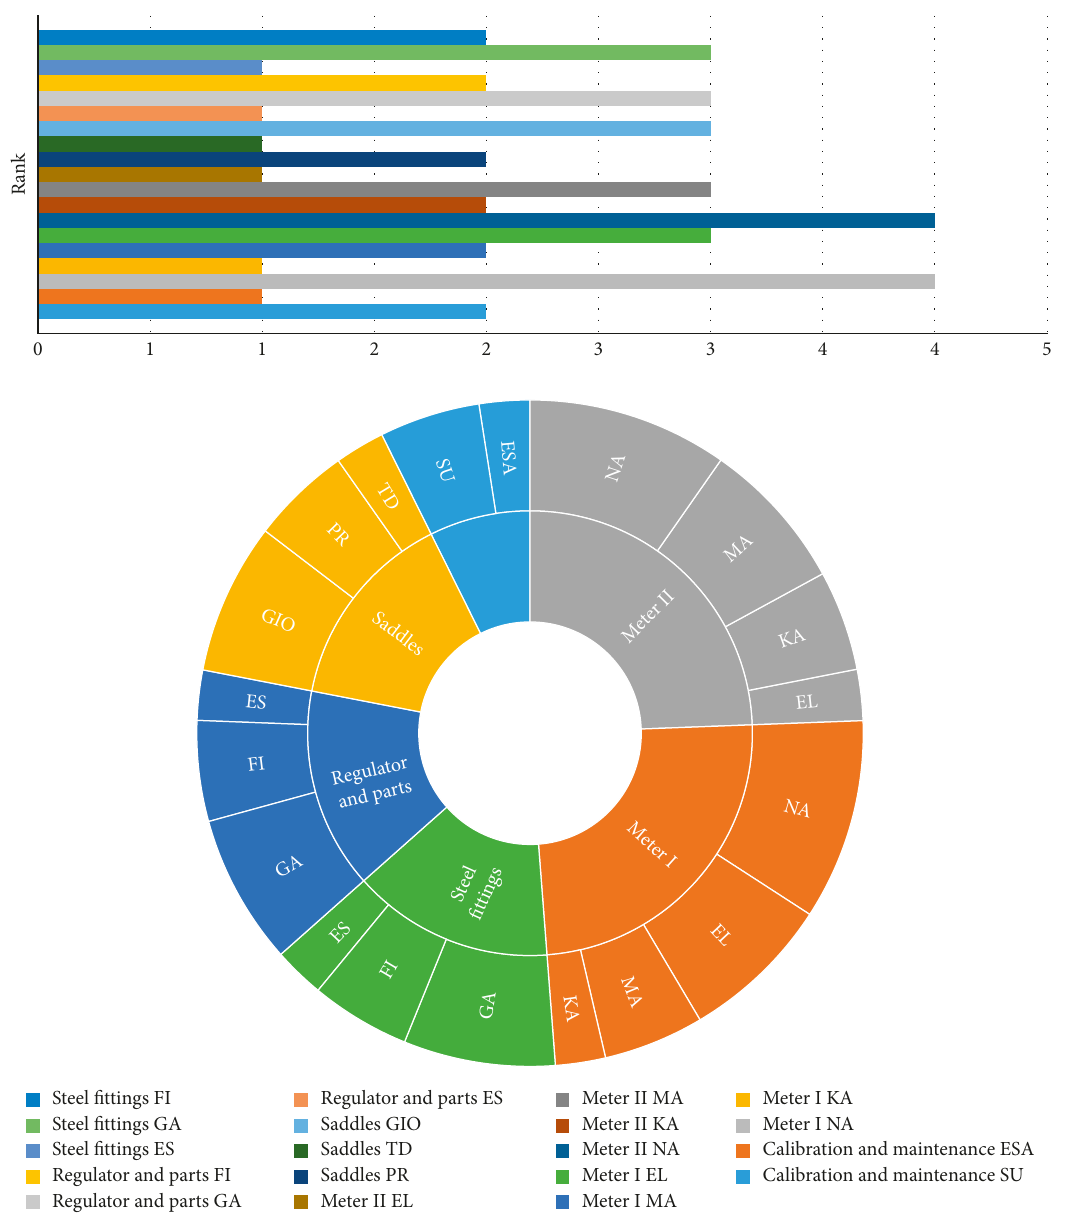
Figure 5: Modification on preference of alternatives according to different item